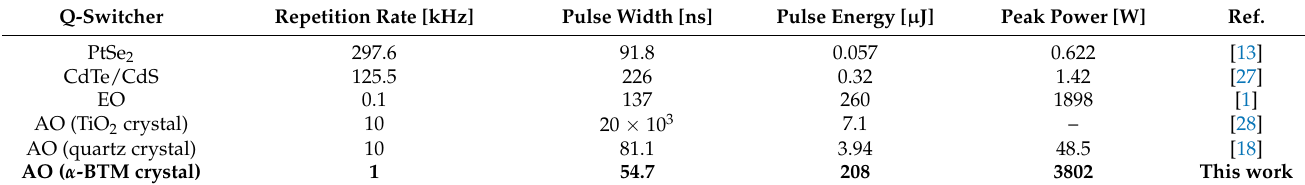
Table 1. The Q-switching output characteristics of Pr-doped pulsed lasers at 639 nm.